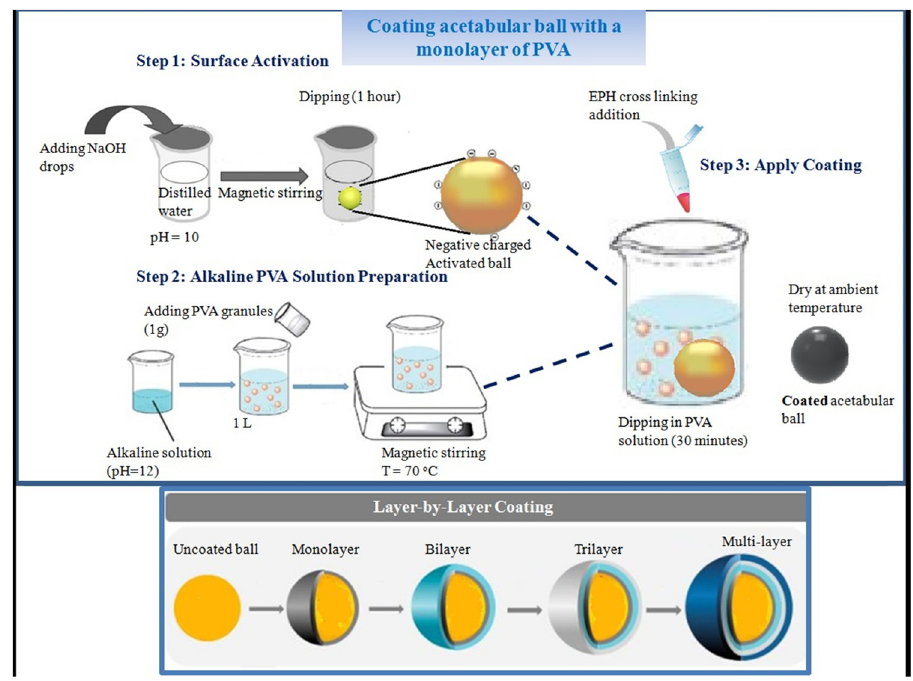
Figure 3: A schematic diagram shows the steps used to coat the acetabular head with a monolayer of